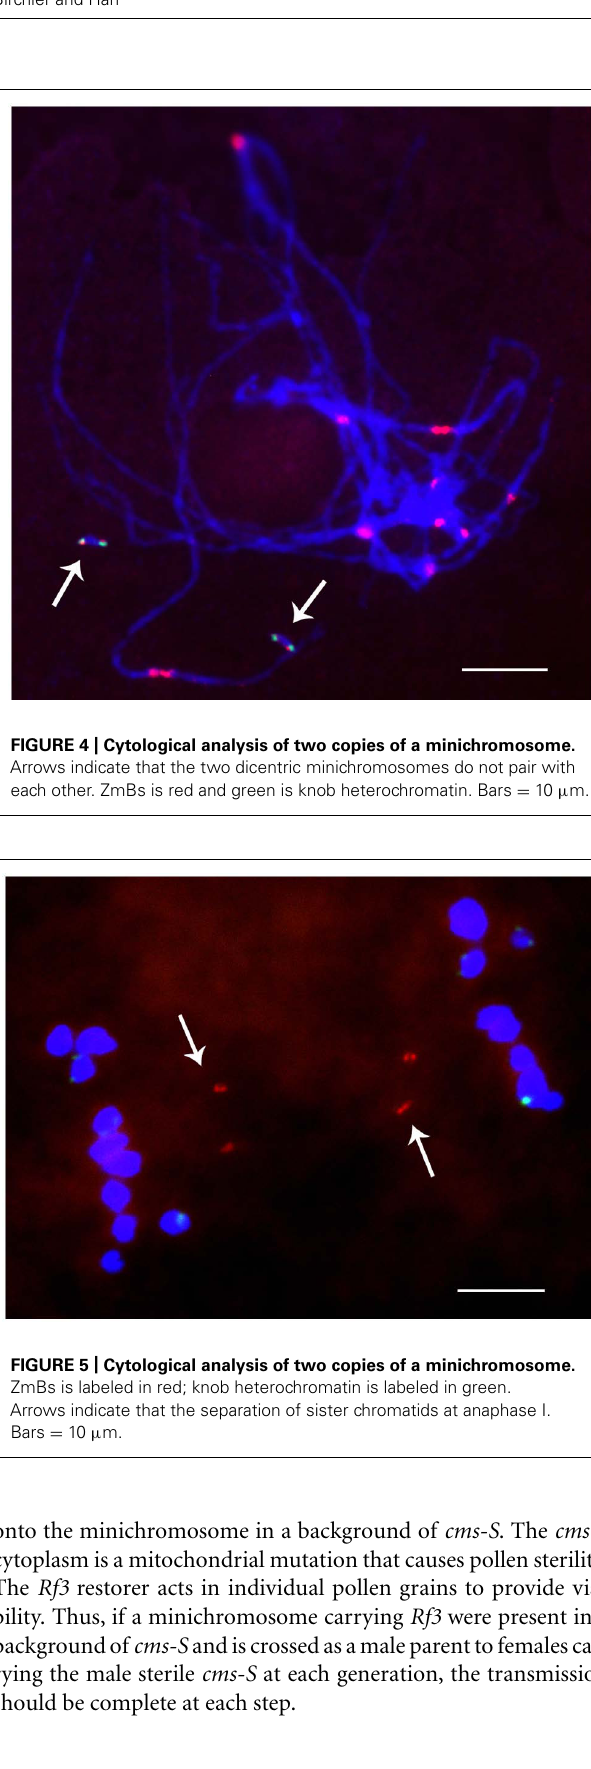
onto the minichromosome in a background of cms-S . The cms-S cytoplasm is a mitochondrial mutation that causes pollen